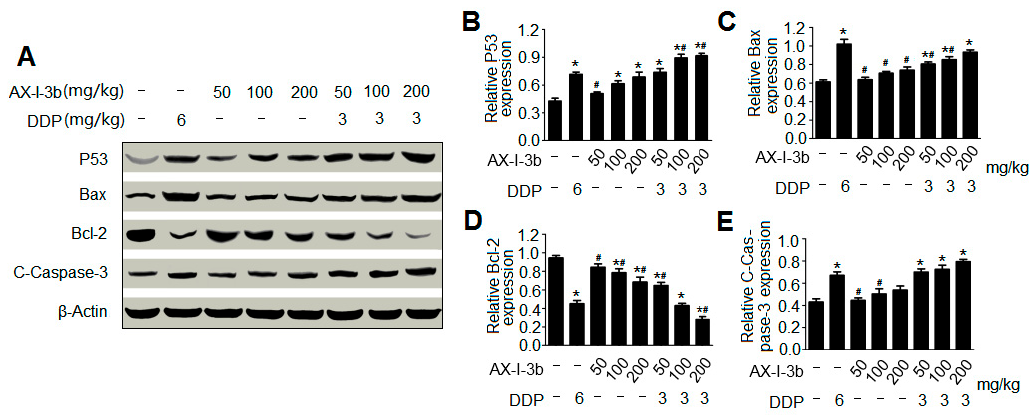
Figure 9. AX-I-3b induced apoptosis in tumor tissues. Data are shown as means ± SD. (n = 3). * p < 0.05 compared with the model group; # p < 0.05 compared with with the DDP group. ( A ) Western blot analysis of expression of apoptotic proteins in tumor tissues; ( B ) The expression of p53; ( C ) The expression of Bax; ( D ) The expression of Bcl-2; ( E ) The expression of caspase-3.